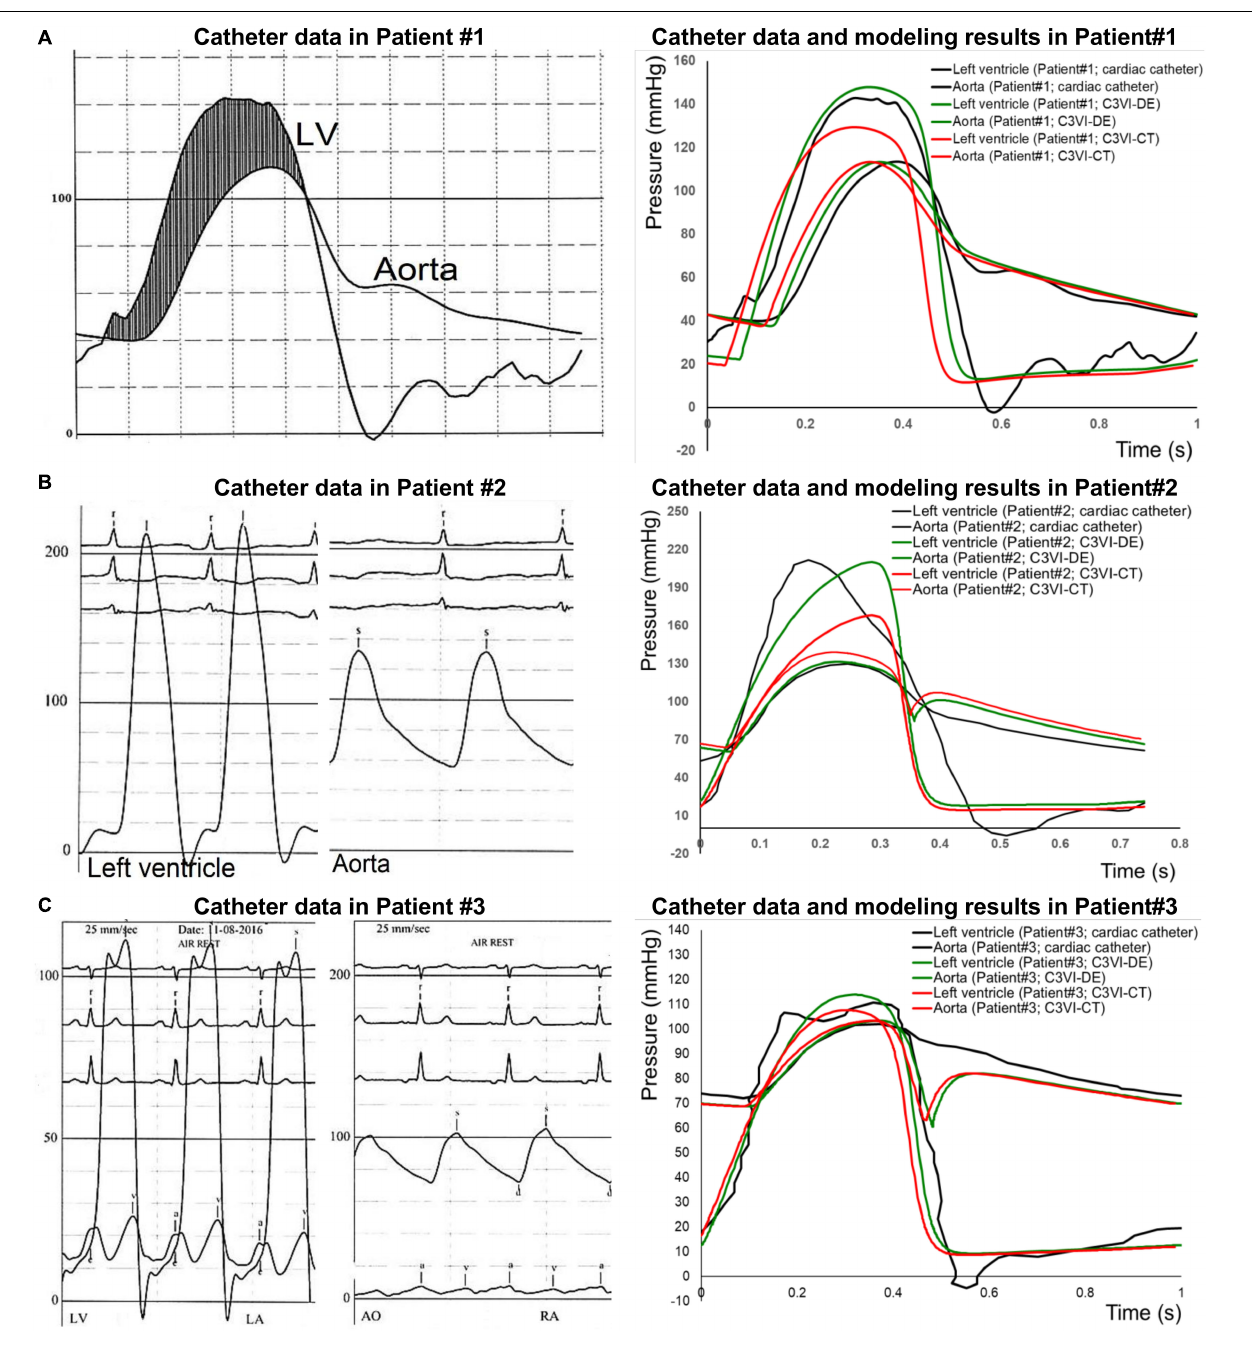
FIGURE 3 | Pressure waveform comparison (C3VI-CT & C3VI-DE vs. cardiac catheter): The instantaneous C3VI-DE pressure compared favorably with cardiac catheter pressure in all subjects. Conversely, results from C3VI-CT do not precisely agree with catheter measurements. (A) Patient #1; (B) Patient #2; (C) Patient